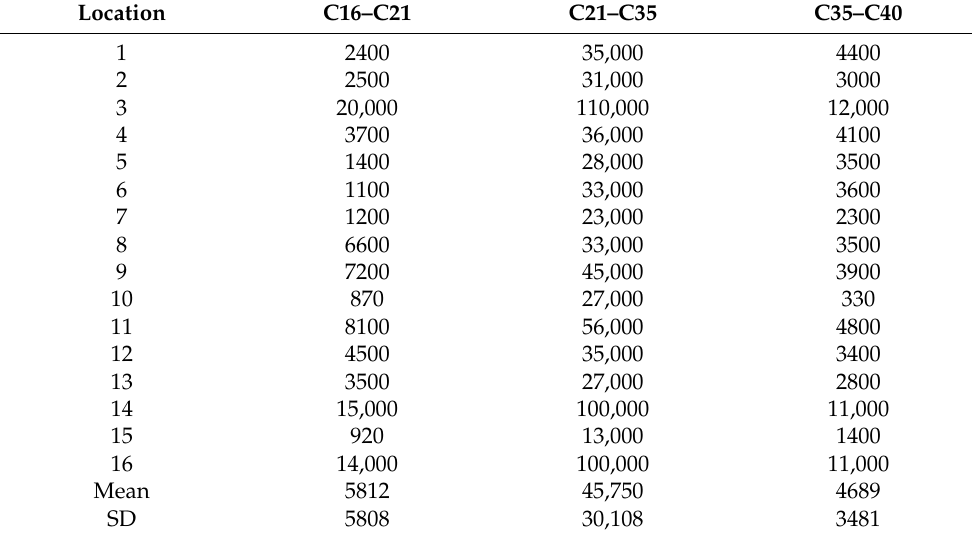
Table 1. Concentrations (mg/kg) of aliphatic hydrocarbons in the oily sludge samples collected from the oilfield waste pit.